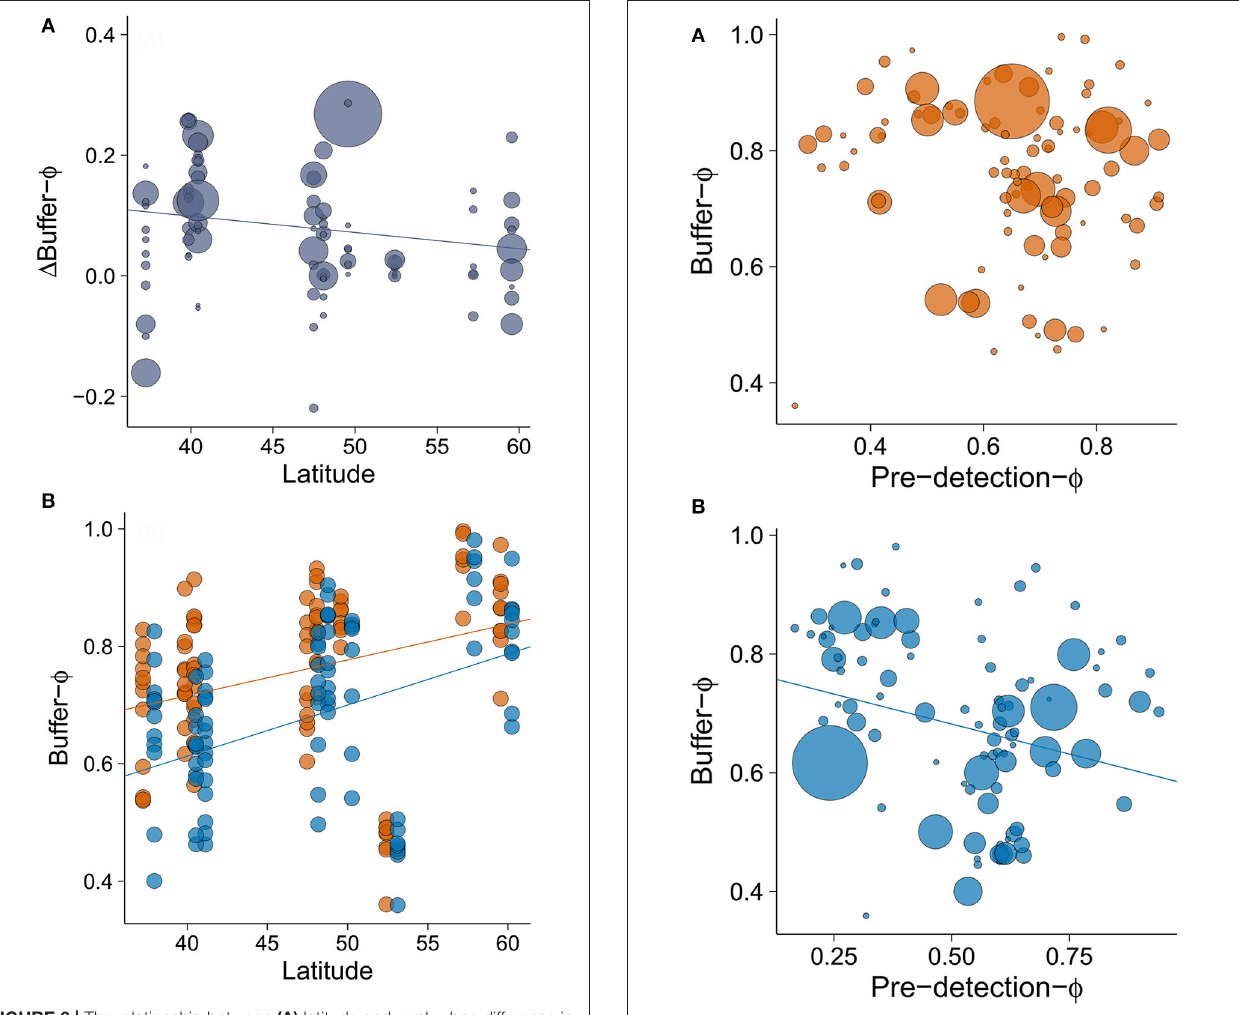
FIGURE 7 | The relationship between pre-detection- 8 and the buffer- 8 for (A) rural and (B) urban populations. Lower values of pre-detection- 8 mean that birds took longer to be alerted to an approaching human, whereas lower values of buffer- 8 mean that birds tolerate more human approach after detection. Circle size is proportional to sample size for a given population (plot A: min = 8, max = 122; plot B: min = 8, max = 275). Line illustrates linear